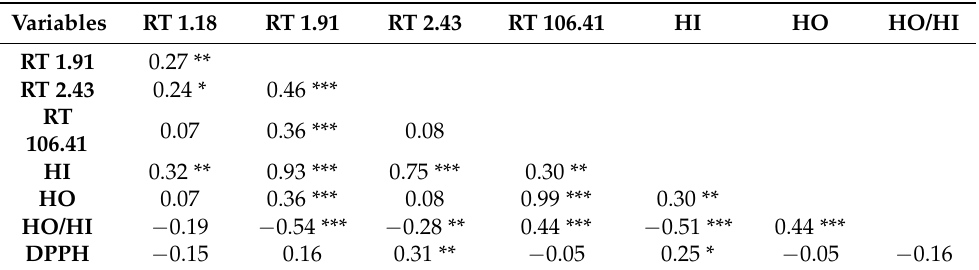
Table 2. Correlation values for retention time, peptides proportion, and antioxidant effect in ASN fraction in Mexican goat cheese with prolonged ripening.